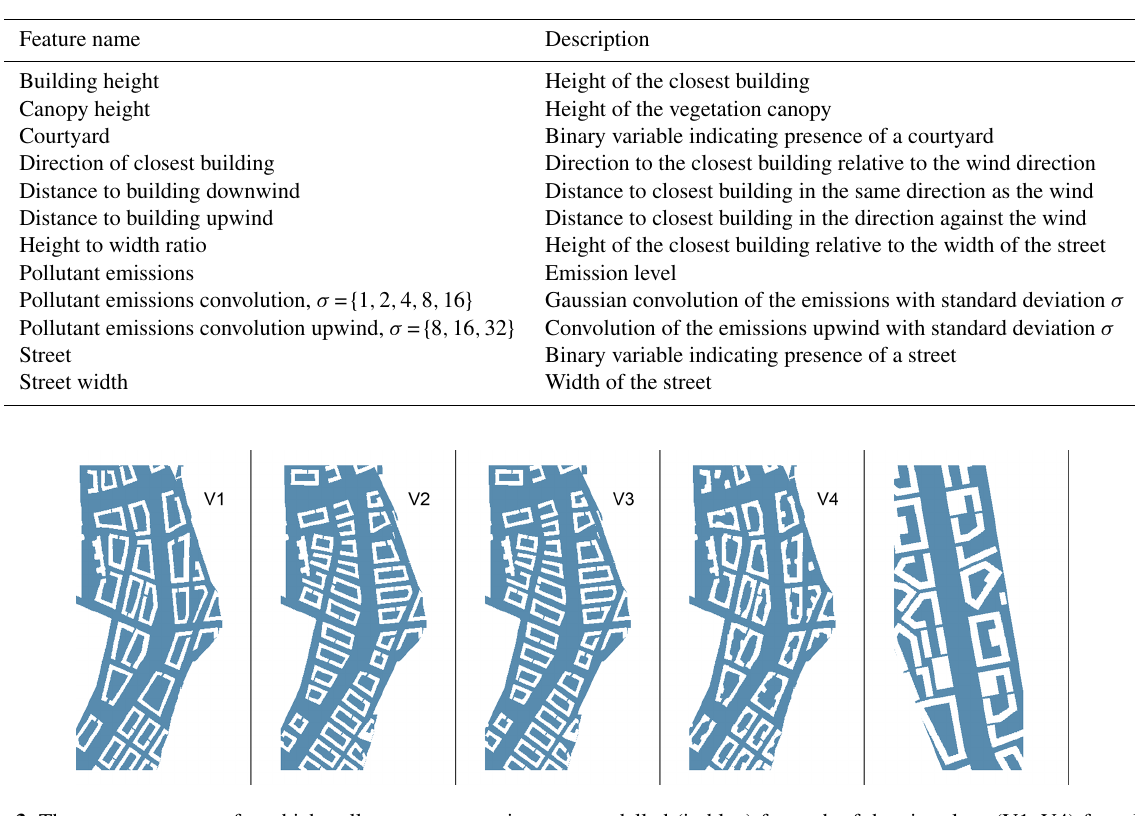
Figure 3. The map area cutout for which pollutant concentrations are modelled (in blue) for each of the city plans (V1–V4) from Kurppa et al. (2018) and for the map area from Karttunen et al. (2020) (rightmost